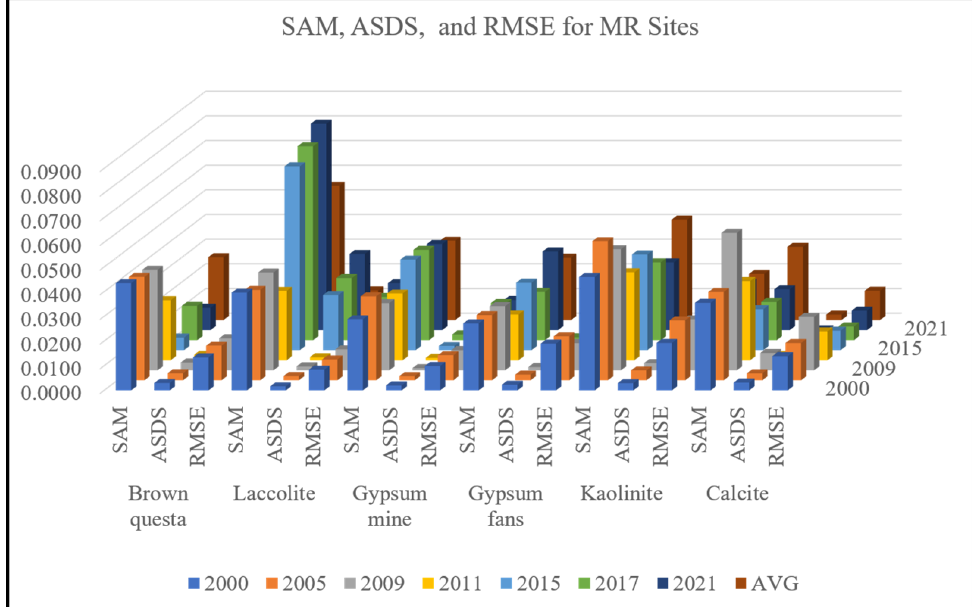
Figure 8. Spectral change examination. SAM, ASDS, and RMSE for each year against the year 1996 (t0).